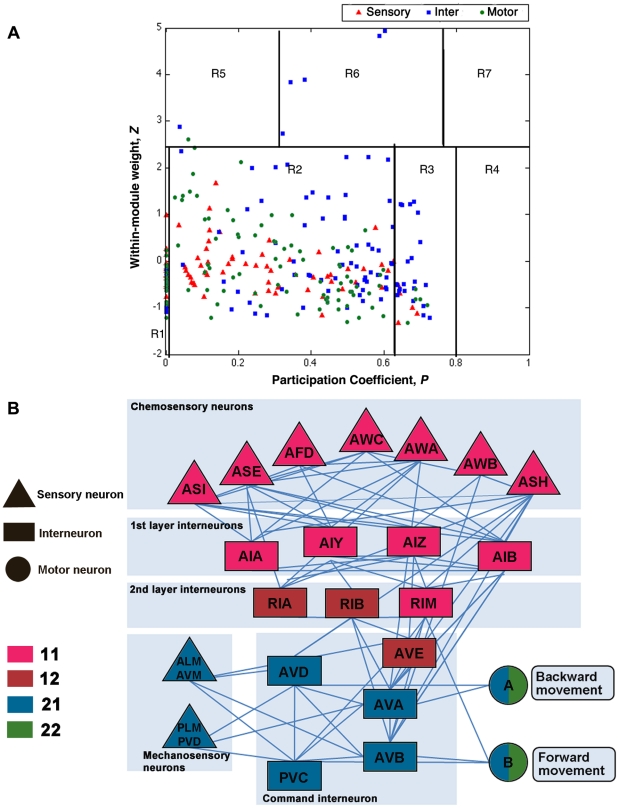
Functional implications of the derived clusters.(A) Functional cartography of neurons in the C. elegans connectome using the within-module weight (Z) and participation coefficient (P) of each neuron. The neurons within each region can be defined as: (R1) ultra-peripheral nodes; (R2) peripheral nodes; (R3) non-hub connector nodes; (R4) non-hub kinless nodes; (R5) provincial hubs; (R6) connector hubs; and (R7) kinless nodes, based on the conventional rules for classification. The exact value ranges of P and Z for each class are denoted in Text S1 (Table S2). (B) Cluster affiliation of neuronal pairs responsible for the behavior of a worm identified by previous biological experiments. The color of each neuronal pair indicates its affiliation to a specific cluster.